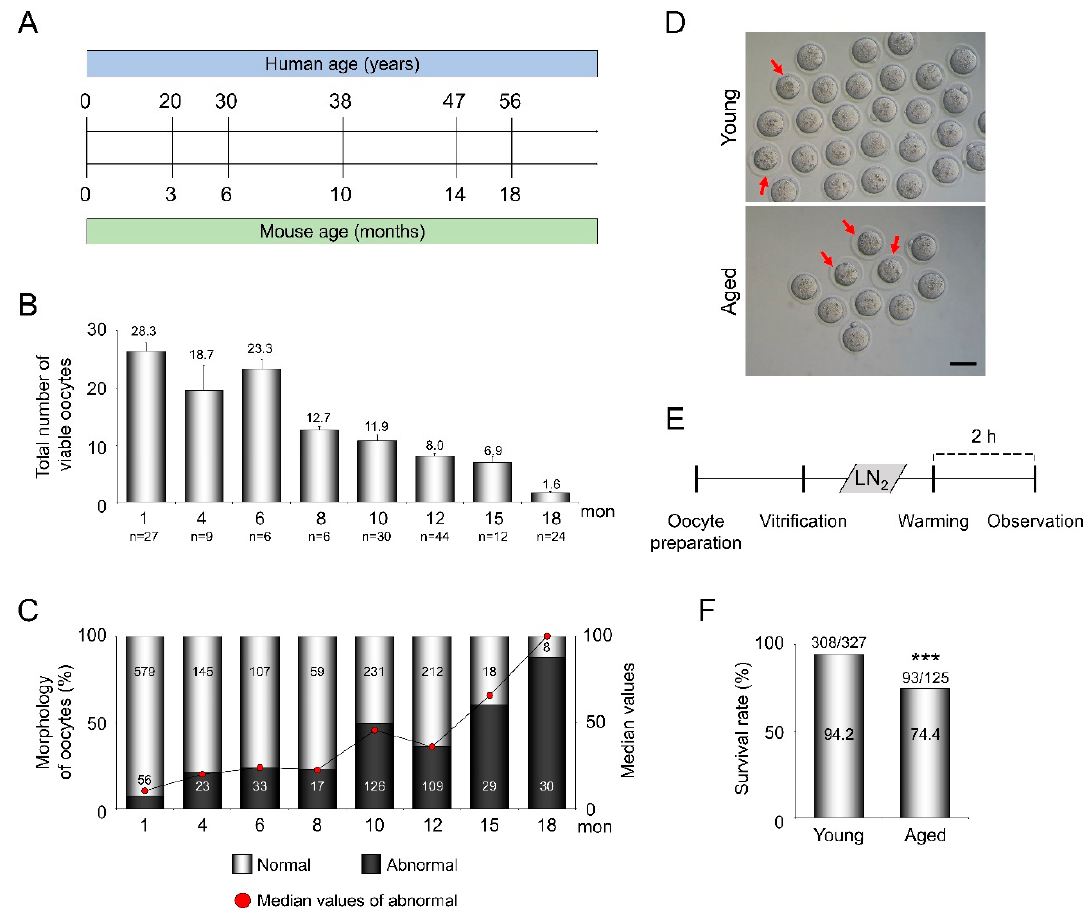
Figure 1. Age-dependent changes in the number and morphological abnormalities of ovulated oocytes. ( A ) A schematic comparison of the life span between humans and C57BL/6 (BL6) mice, which has been modified from “Mouse models in aging research” [23]. ( B ) The total number of ovulated oocytes from BL6 mice by age (from 1- to 18-month-old). The graph presents the average number of ovulated oocytes per mouse ( n = 6–44 mice in each group). ( C ) An age-dependent increase in morphologically abnormal oocytes (1- to 18-month-old). White and black bars represent the percentage of normal and abnormal oocytes, respectively ( n = 38–635 oocytes in each group). Red dots represent the median values in each group. ( D ) Representative microscopic images of ovulated oocytes from young and aged BL6 mice after superovulation. Red arrowheads indicate morphologically abnormal oocytes. ( E ) A schematic diagram to illustrate the experimental procedures to evaluate whether the survival rates of oocytes from young and aged mice are different between strains after vitrification. ( F ) Comparison of the survival rates of VW oocytes from young (1- to 2-month-old) and aged (10- to 12-month-old) mice. The graphs present the survival rate of total ovulated VW oocytes ( n = 125–327 oocytes in each group). Scale bar = 75 µm. Statistical comparisons were performed using chi-squared test. *** p < 0.005.